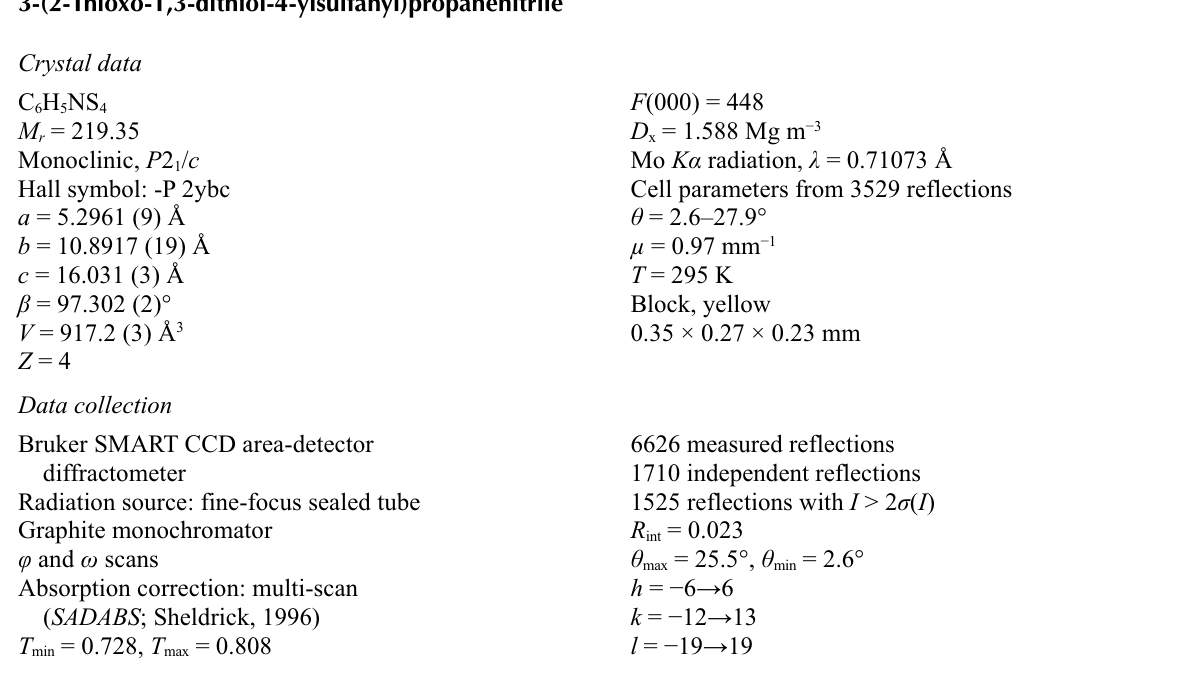
Crystal packing of the title compound viewed down the a